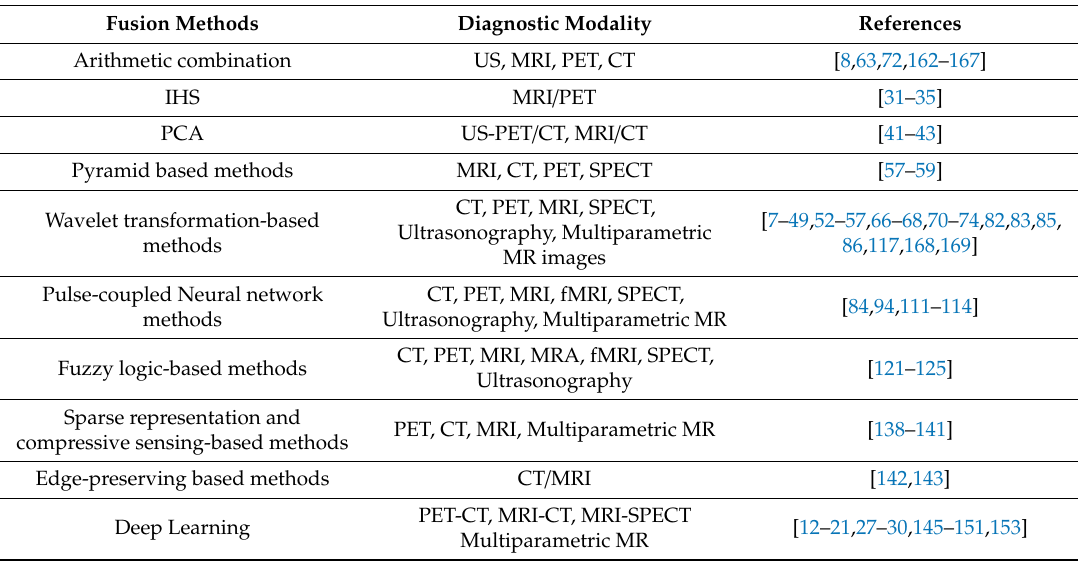
Table 1. Major medical image fusion